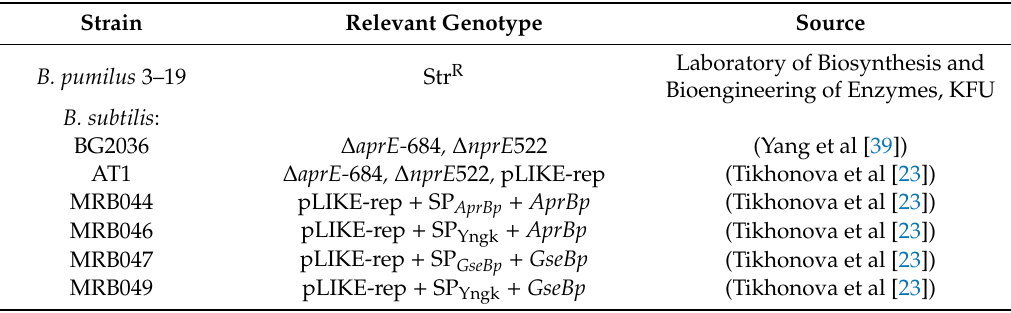
Table 3. Bacterial strains used in this